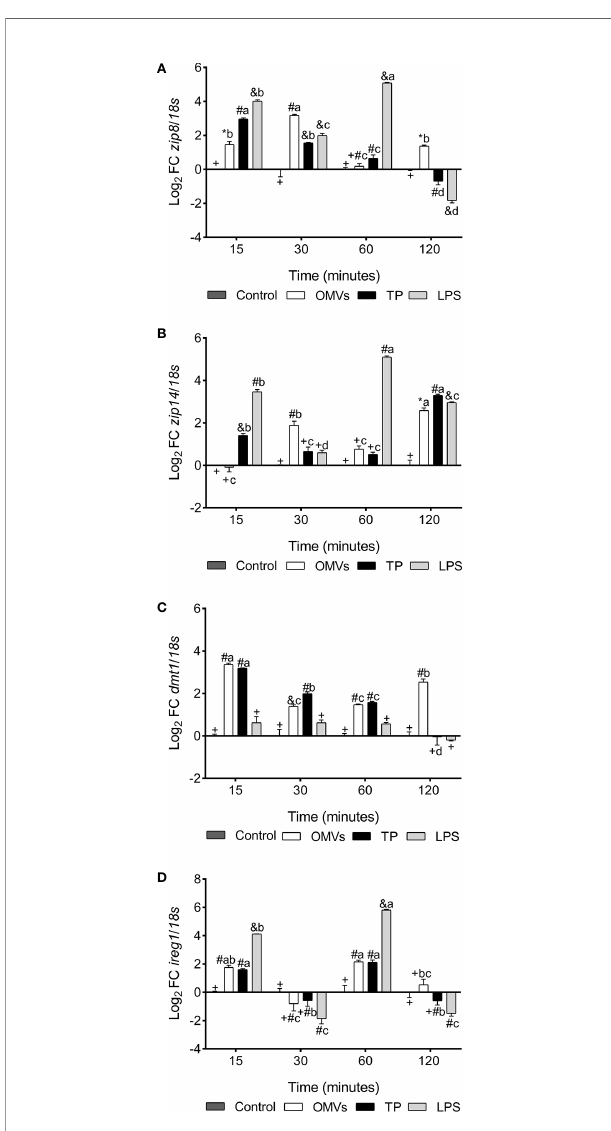
FIGURE 1 | Transcription of zip8 (A) , zip14 (B) , dmt1 (C) and ireg1 (D) in SHK-1 cell line stimulated with 1 m g each PAMPs of P. salmonis at 15-, 30-, 60- and 120-minutes post-stimulation. Expression analysis of mRNA was performed by qPCR and 18s was used for normalization. Symbols over the bars indicate statistical differences between the different treatments at the same time points. Different letters indicate statistical differences in the same treatment at different times. Two-way ANOVA, p < 0.05;